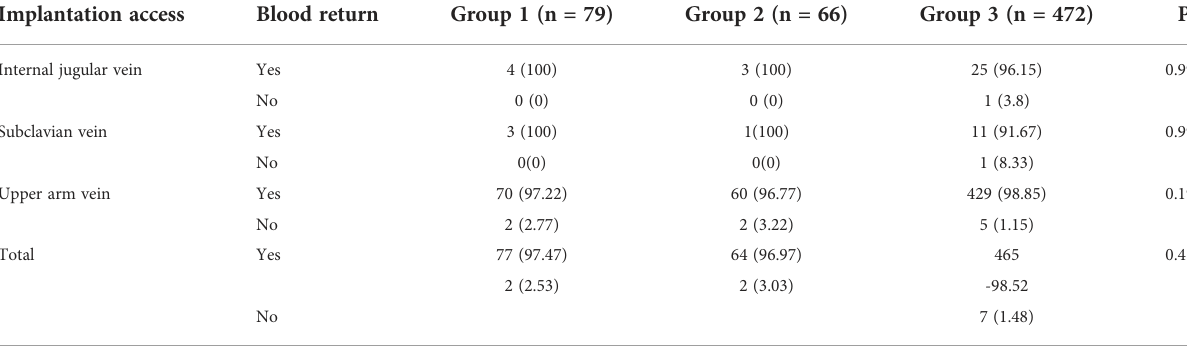
TABLE 2 Comparison of TIVAP-related blood return rate among the three groups. Implantation access